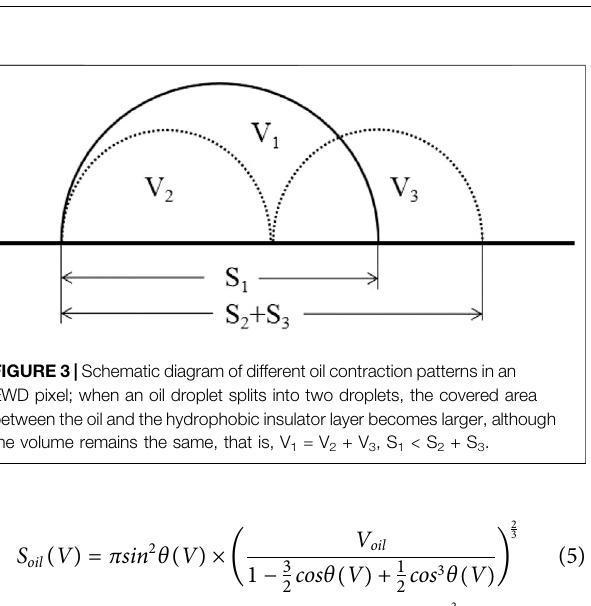
FIGURE 4 | Charge trapping phenomenon of EWDs. When applying a driving voltage, ions in the water move toward the insulator due to the electrostatic force, and then the oil is pushed aside. Some ions move into the insulator and become trapped. Even when removing the driving voltage, the oil could not cover the entire hydrophobic